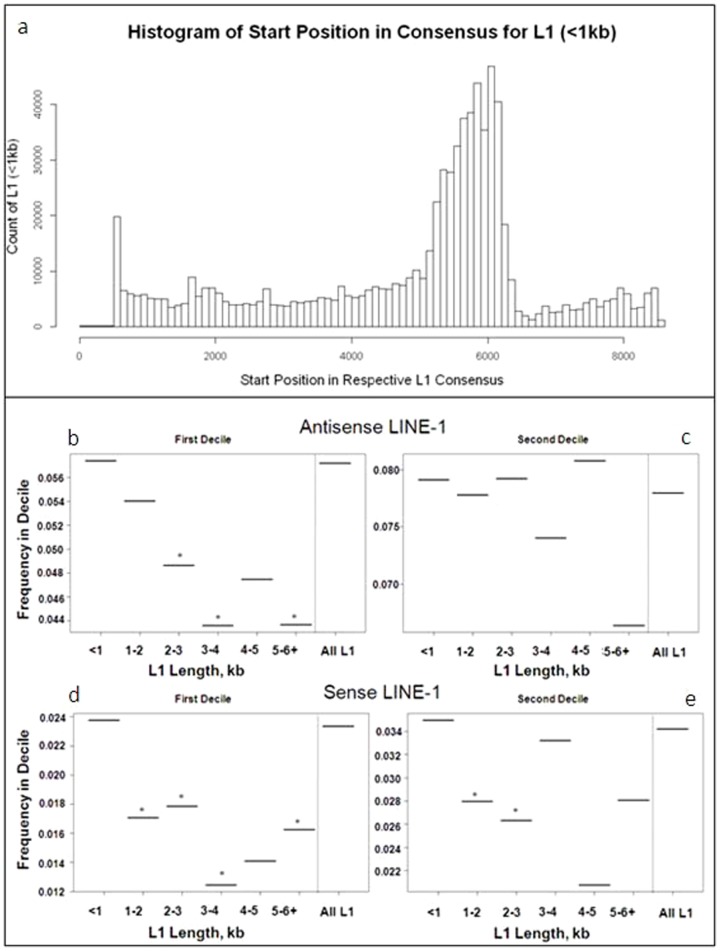
Full-length L1 are reduced near the 5′-UTR of genes.a) Histogram of the start position within the L1 consensus sequence of L1 that are less than 1 kb. The L1 promoter lies between approximately 1–1000 bp depending on the consensus. The peak of where L1<1 kb start in the respective consensus sequence is shifted towards 6 kb. b–e) L1 were subdivided by length into groups of <1 kb, 1–2 kb, 2–3 kb, 3–4 kb, 5 kb>, or all L1 within genes. Frequencies of antisense (top row) and sense (bottom row) that fell within the first (left column) or second (right column) gene deciles were then calculated for each group of L1. L1 located in the first decile of genes showed a reduced frequency with increasing size of the element for both antisense and sense L1 (* = Fischer's two-sided p-values significant after Bonferroni correction).